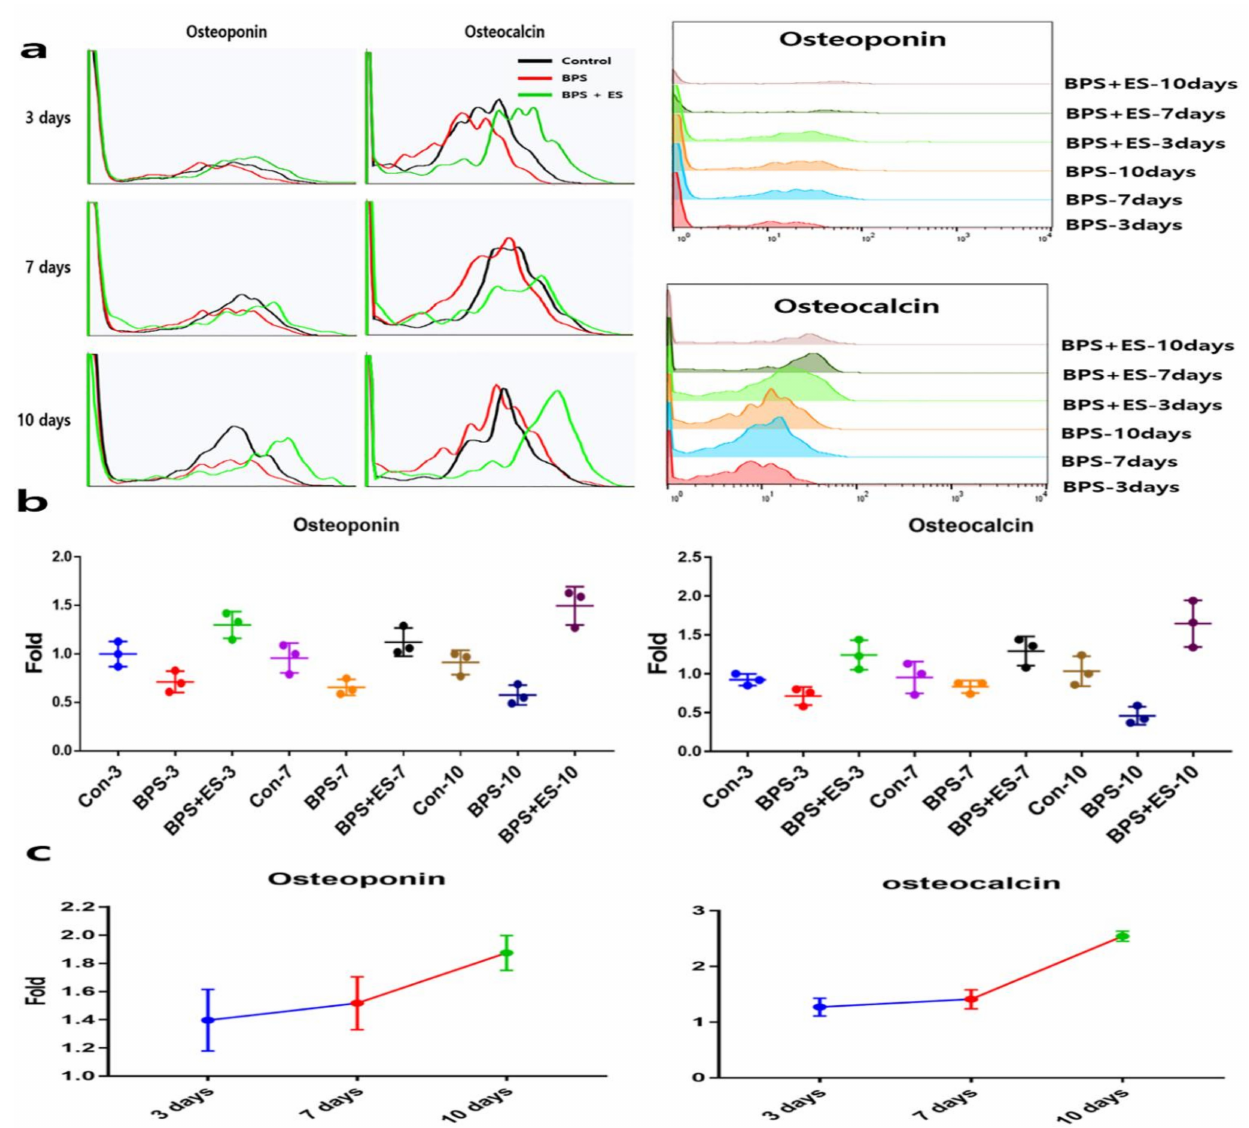
Figure 5. Protective effect of black jade extract on osteoblastic differentiation in adipose-derived stem cells (ASCs) under conditioned mediums. These results are from ASCs under conditioned mediums (BPS, BPS+EX). ( a ) Histograms indicating cell counts and expression levels for the osteoponin and osteocalcin detected using flow cytometry. ( b ) Relative fold changes for cell counts in the corresponding graphs. ( c ) Relative fold changes between BPS and BPS+ES. After exposure to ES, ASCs were exposed to BPS. The conditioned medium (BPS) contained the supernatant from the fibroblast cells exposed to benzo(a)pyrene. The conditioned medium (ES) contained the supernatant from the fibroblast cells exposed to the extract. Con; Control, ( p < 0.05, n =